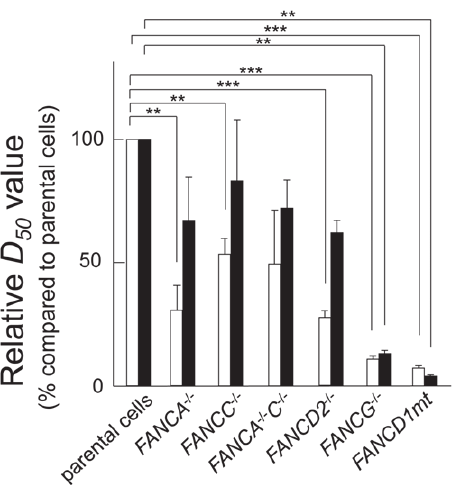
Figure 3. Relative D 50 values (% compared to proficient cells) for ACNU (open columns) and TMZ (closed columns). Two asterisks (**), P , 0.01; three asterisks (***), P , 0.001.